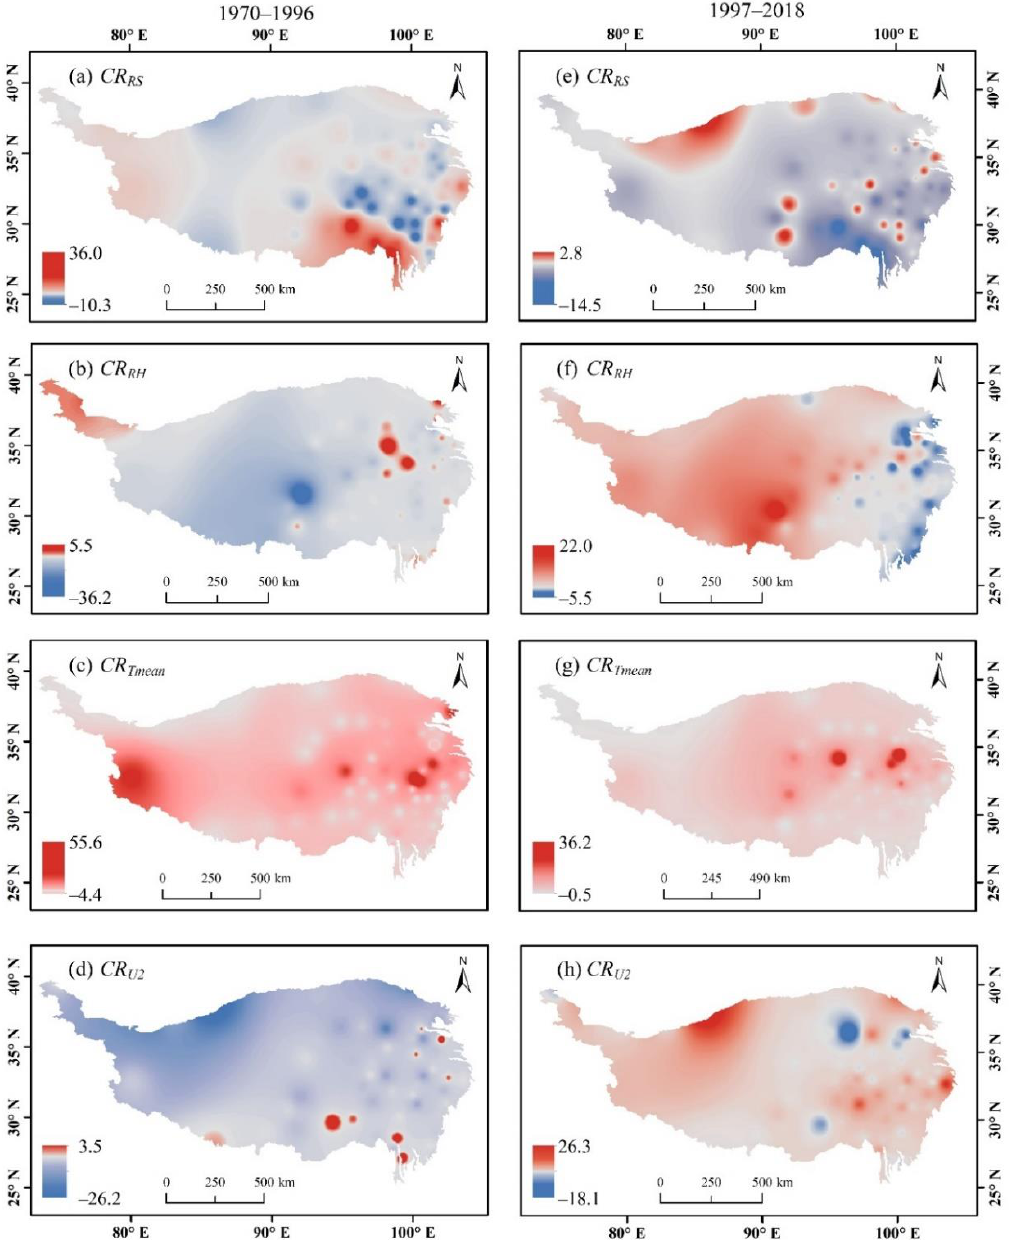
Figure 8. Spatial distribution of contribution rates of four climatic factors to ET 0 during 1970–1996 ( a – d ) and 1997–2018 ( e – h ) (%); ( a , e ) CR RS ; ( b , f ) CR RH ; ( c , g ) CR T mean ; ( d , h ) CR U 2